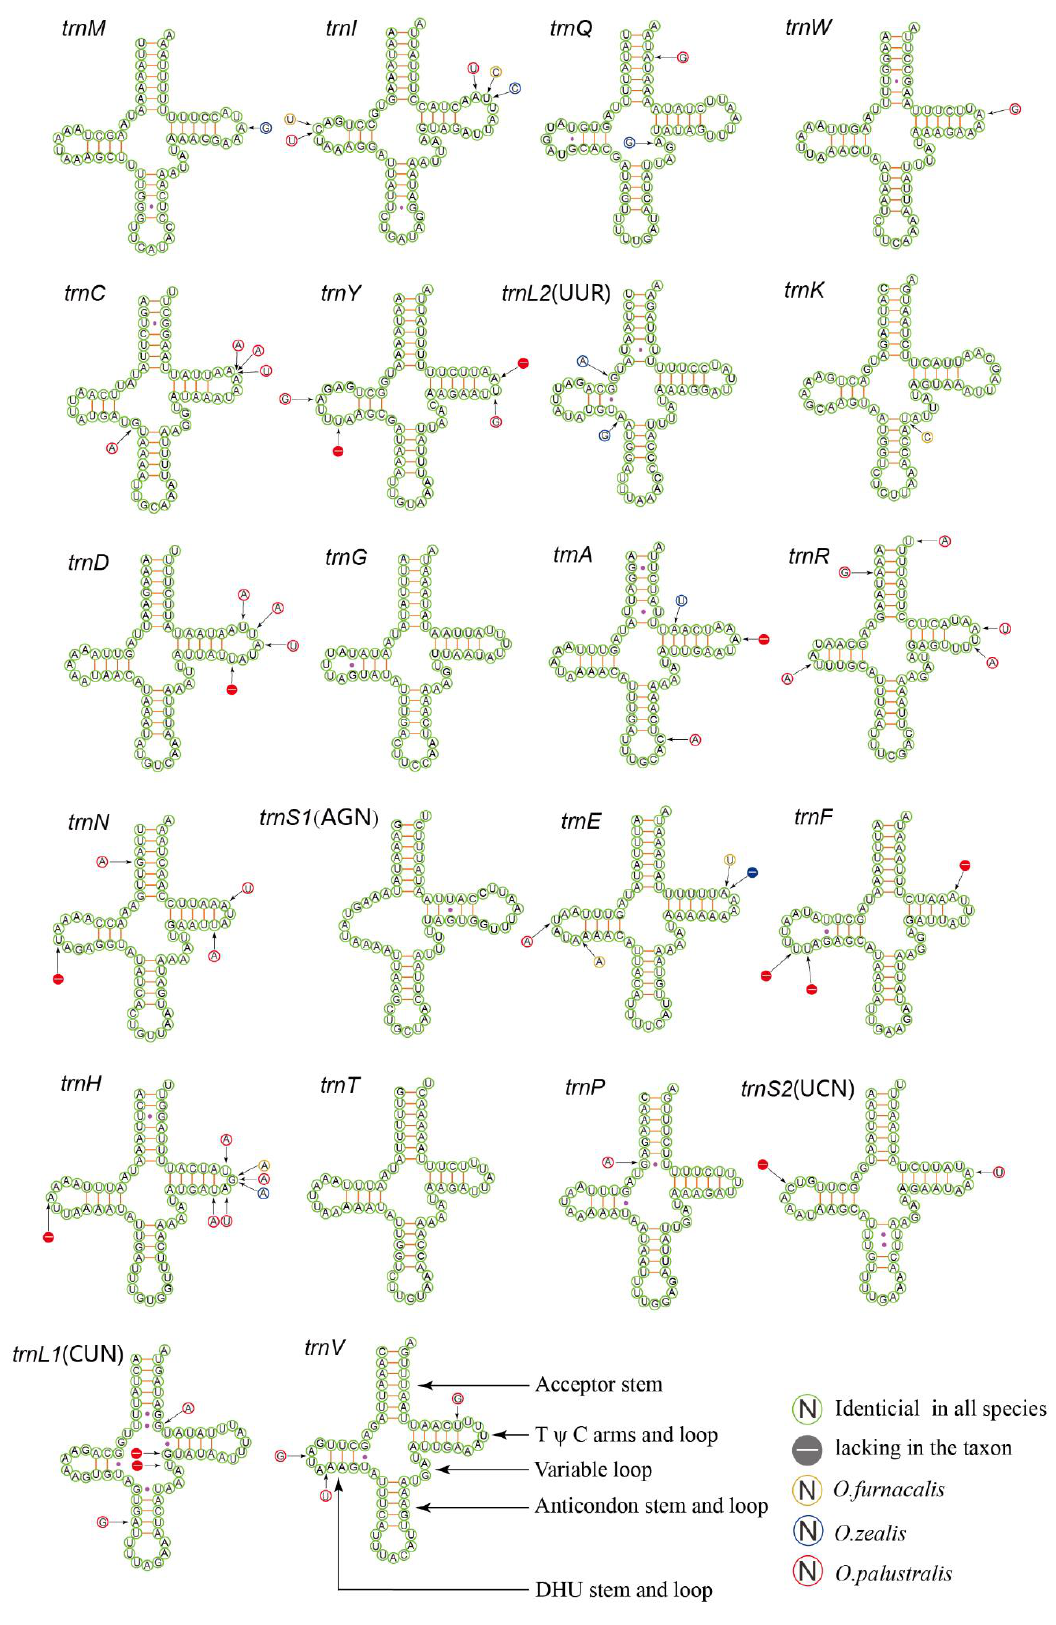
Figure 3. Predicted secondary cloverleaf structure for the tRNAs of O. furnacalis , O. nubilalis , O. scapulalis , O. zealis , and O. palustralis .